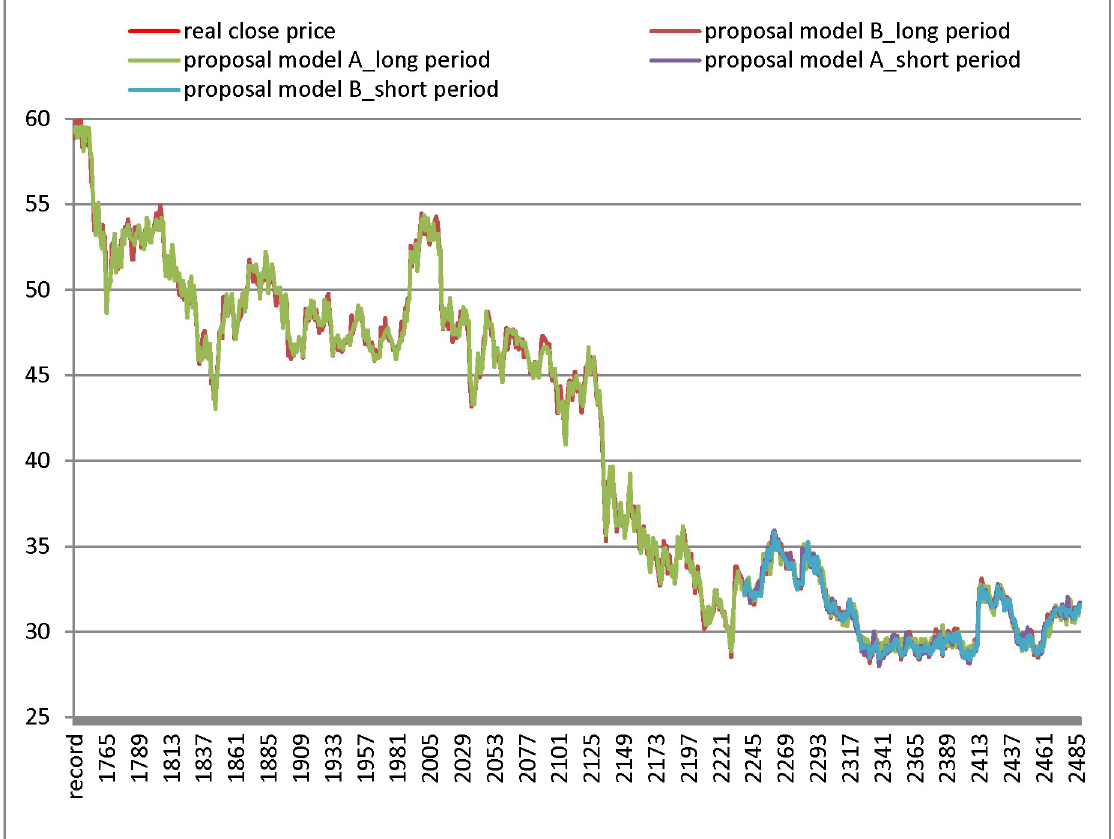
Fig 5. Results of forecasting short and long test period for Cathay Financial